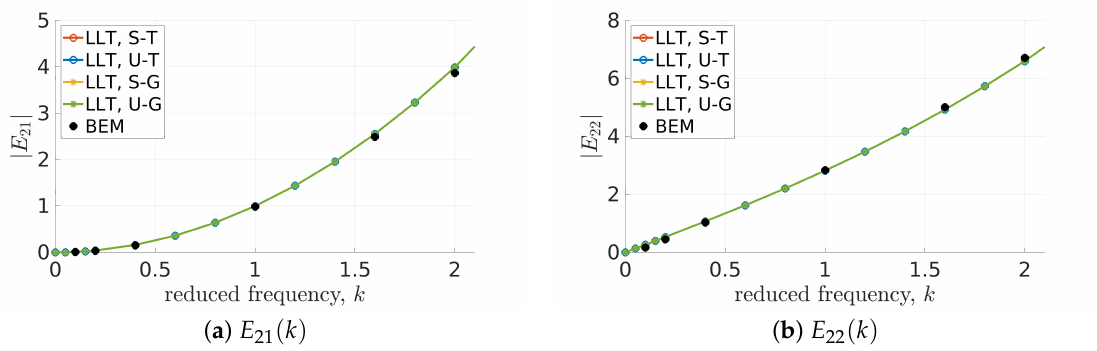
Figure 6. Magnitude of transfer functions E 21 ( k ) and E 22 ( k ) , NMV shape functions, l =